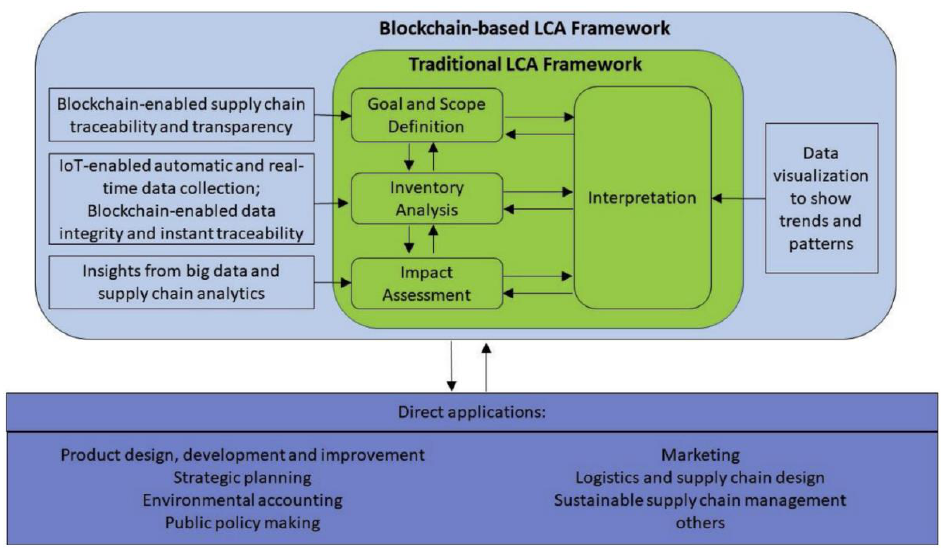
Figure 4. Blockchain-based LCA Framework. Source: Zhang, A. et al. Blockchain-based life cycle assessment: An implementation framework and system architecture, Resources, Conservation and Recycling. Volume 152, January 2020, https://doi.org/10.1016/j.resconrec.2019.104512, p. 4 [85].